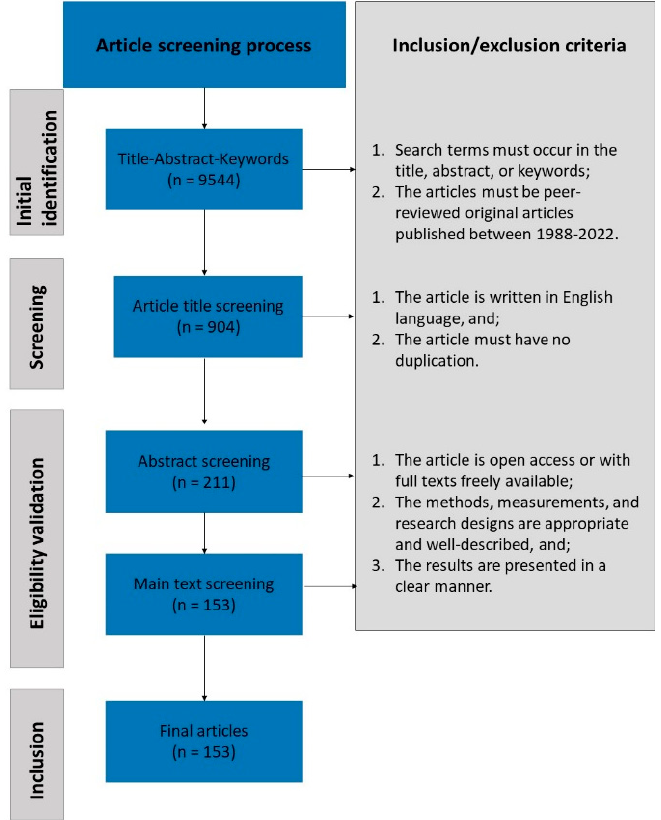
Figure 1. Flow chart of inclusion and exclusion of peer-reviewed articles for the systematic review.